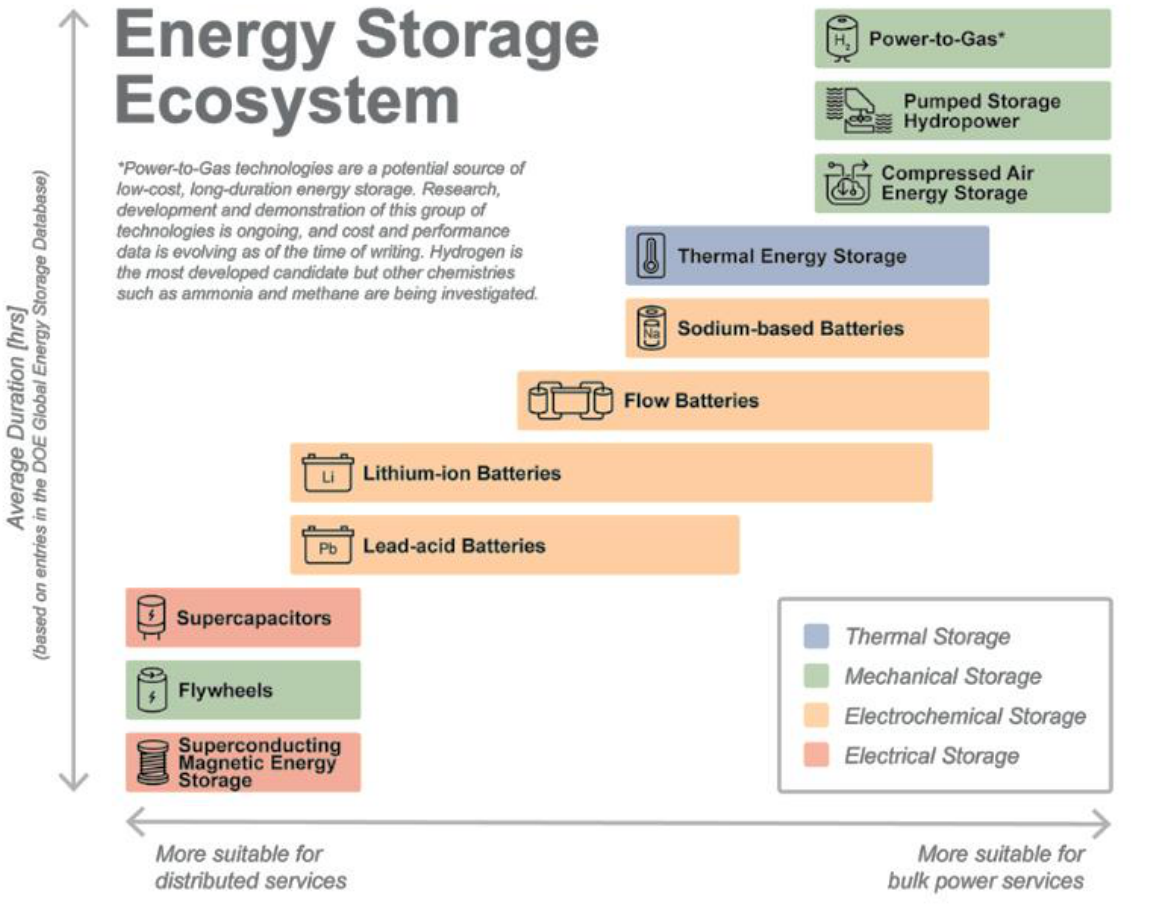
Figure 6. Ecosystem of energy storage technologies and services [19].